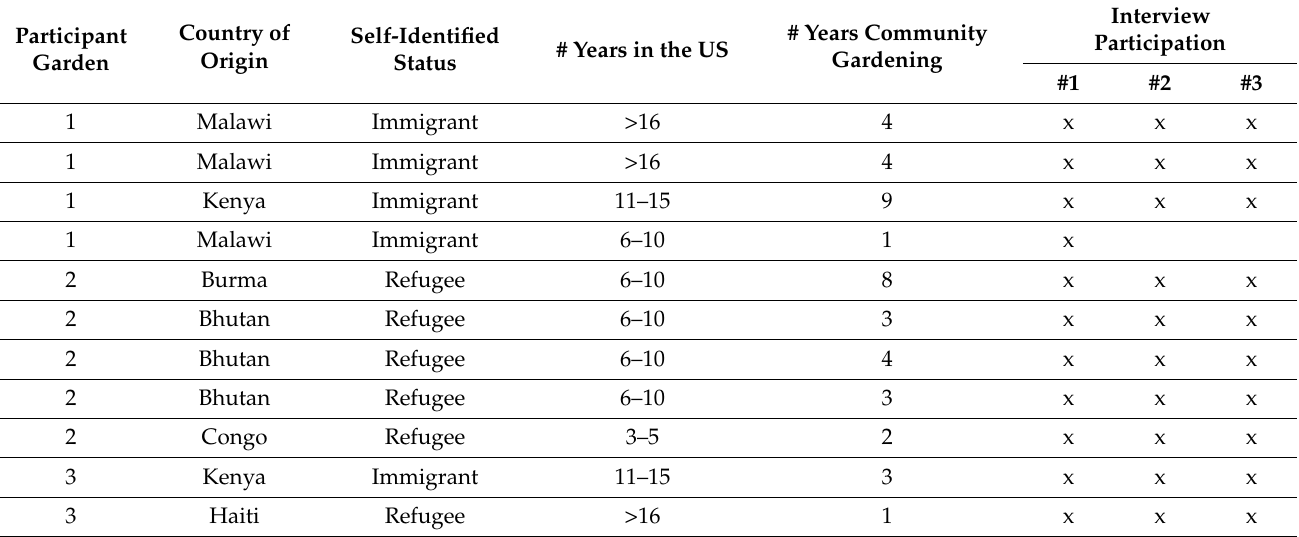
Table 2. Sample population garden affiliation, origin countries, immigrant/refugee status, number of years in the US, number of years gardening in the community, and interview participation.